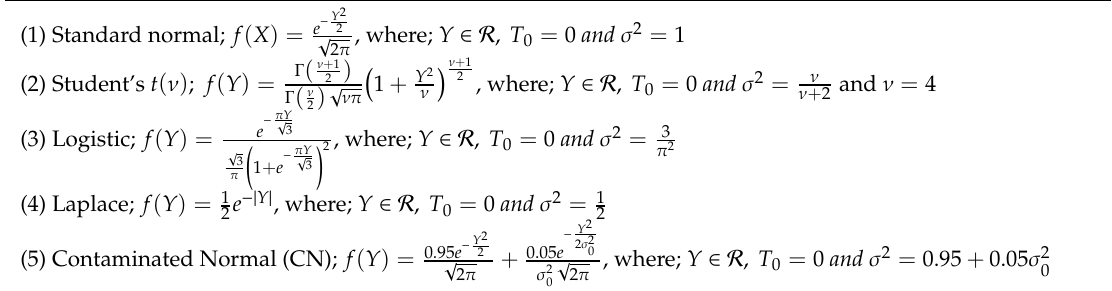
Table 3. Density functions of the continuous distributions that are under